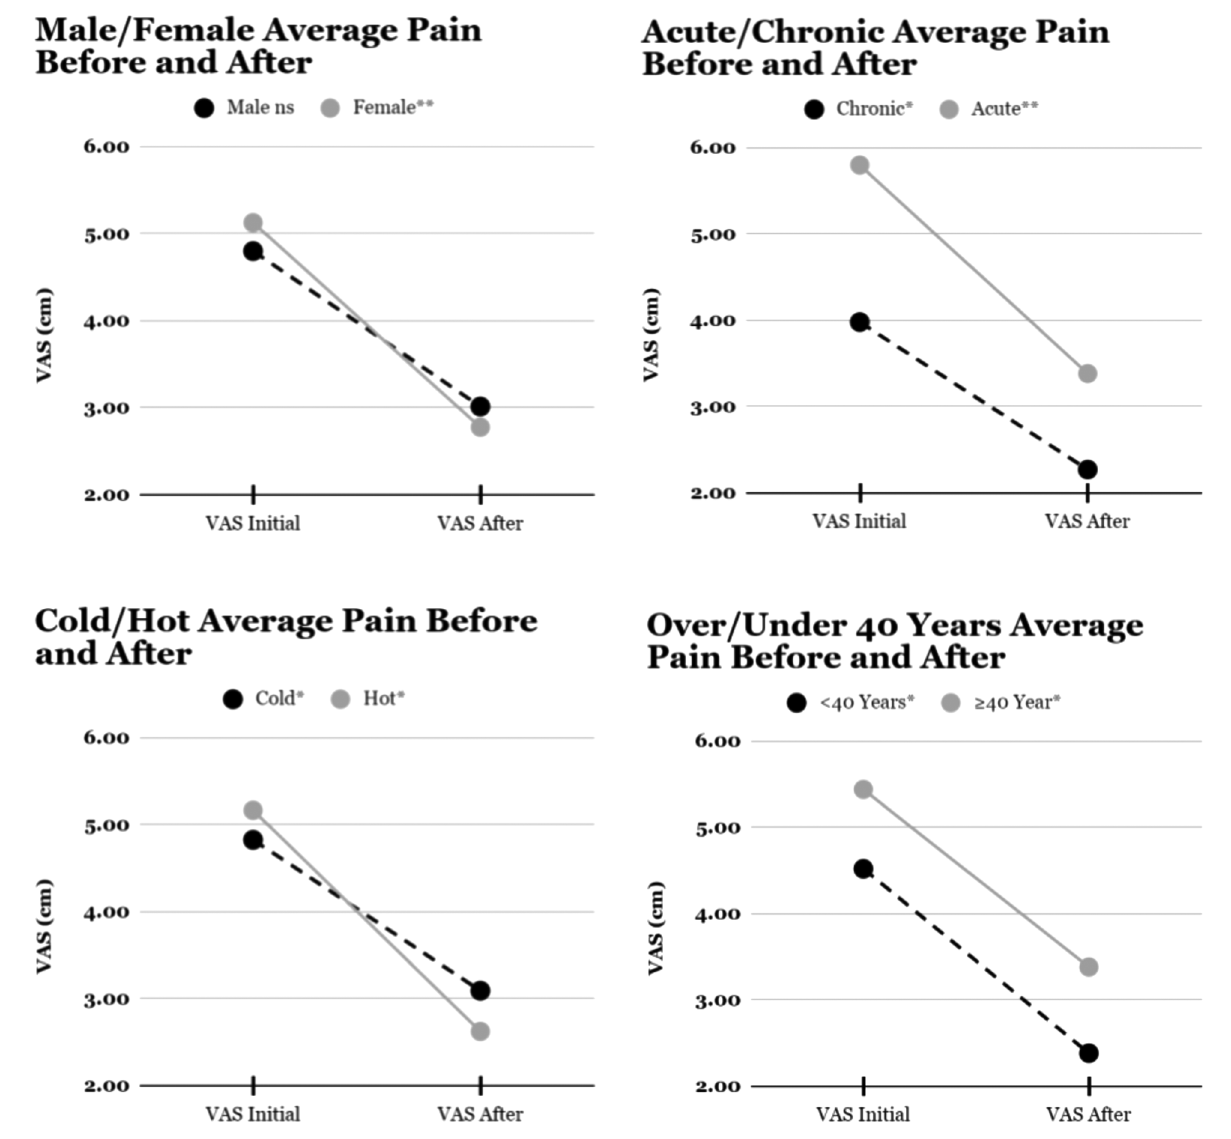
FIGURE 2 Mean visual analogue scale for pain before and after multimodal mechanical stimulation. * p <0.05, ** p <0.01, ns p